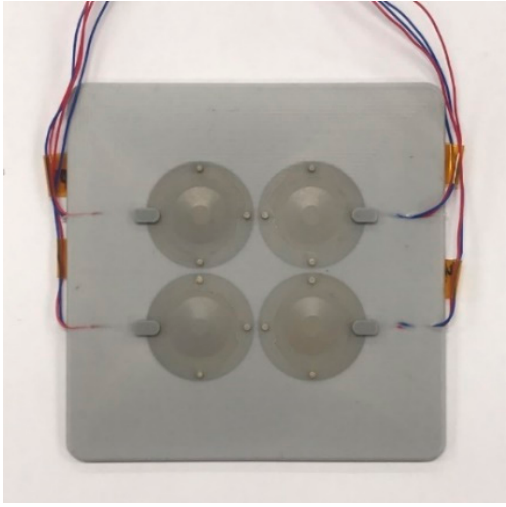
Figure 9. Photograph of the 2 × 2 cymbal array prototype after the second coating.